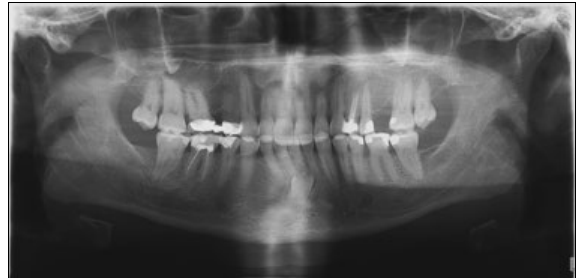
Figure 5. Panoramic radiograph of a patient showing transmigration of the right mandibular canine. transmigrated or not) revealed resorption of adjacent teeth in 18 patients, which went undetected on conventional radiographs. However, no further comparison of the conventional and CBCT images of those patients was